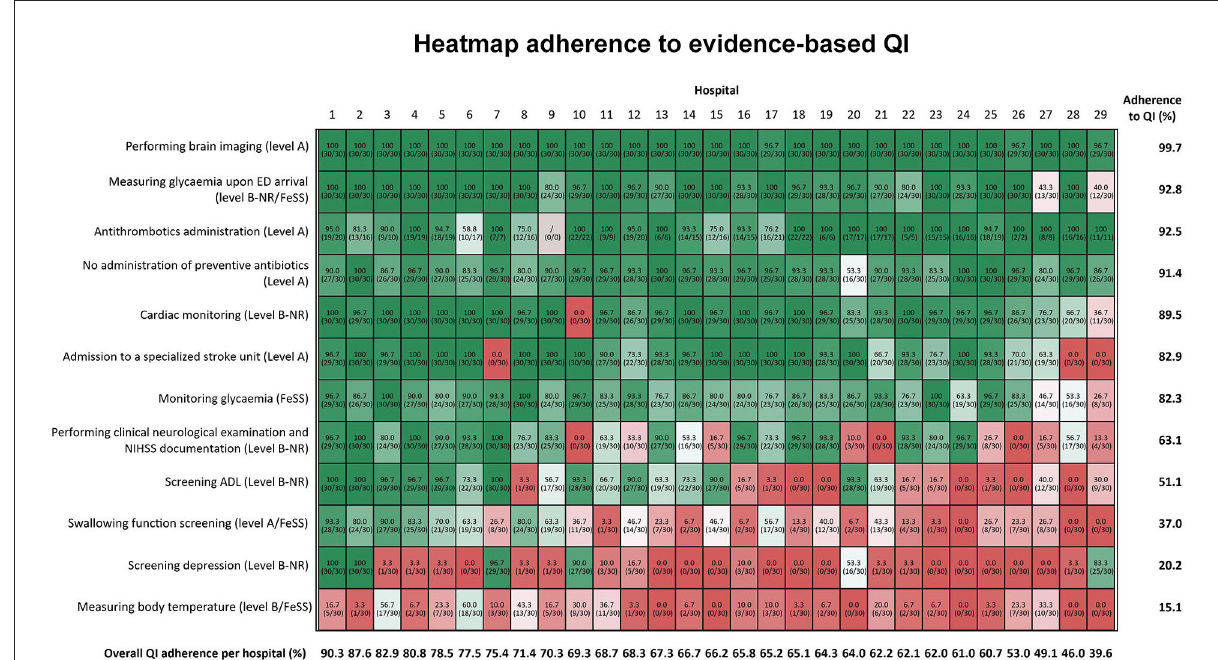
FIGURE1 The hospitals’ randomization numbers are plotted in columns and QI is depicted in rows of the figure. From top to bottom, the figure is sorted according to total mean adherence ratio for each indicator, which is shown in the right vertical axis. From left to right, the figure is sorted by total mean QI adherence rate for each hospital, which is depicted at the bottom horizontal axis of the figure. The darker red the color of the cells, the poorer the adherence ratio. If no information was found in the record, this was analyzed in a similar way as “not performed”. For all the QI, patient records of all the 30 patients were included in the denominator ( n = 30), except for antithrombotic administration. For this indicator, only the patients, for whom antithrombotic administration was the primary therapy, were included for the calculation of this QI. FeSS, Fever, Sugar, Swallowing protocol; ADL, activities of daily living; QI, quality